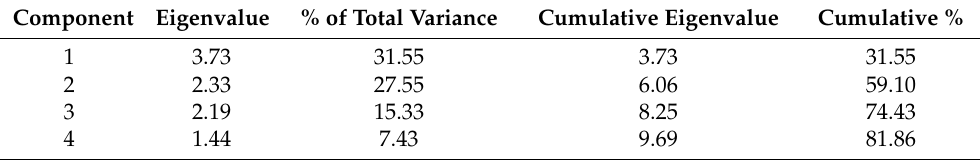
Table 5. Basic statistics for each of the four principal components selected using the CCPCA a method. Component